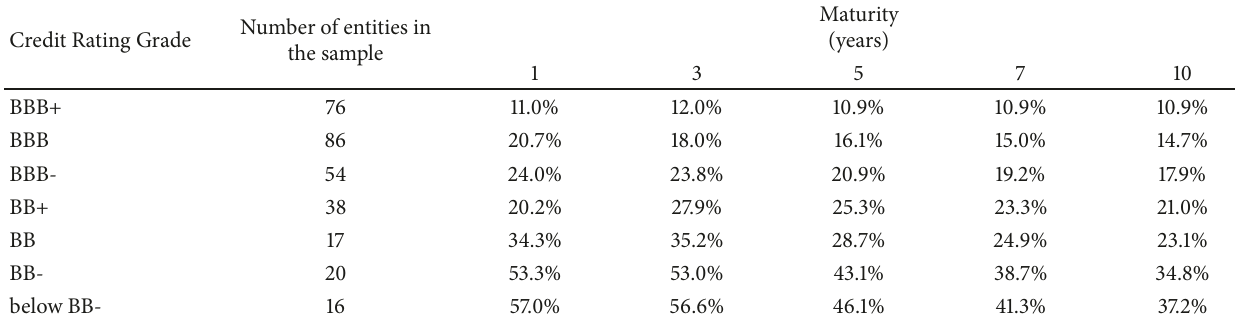
Table 1: Term structures of CDS WDCs for selected rating